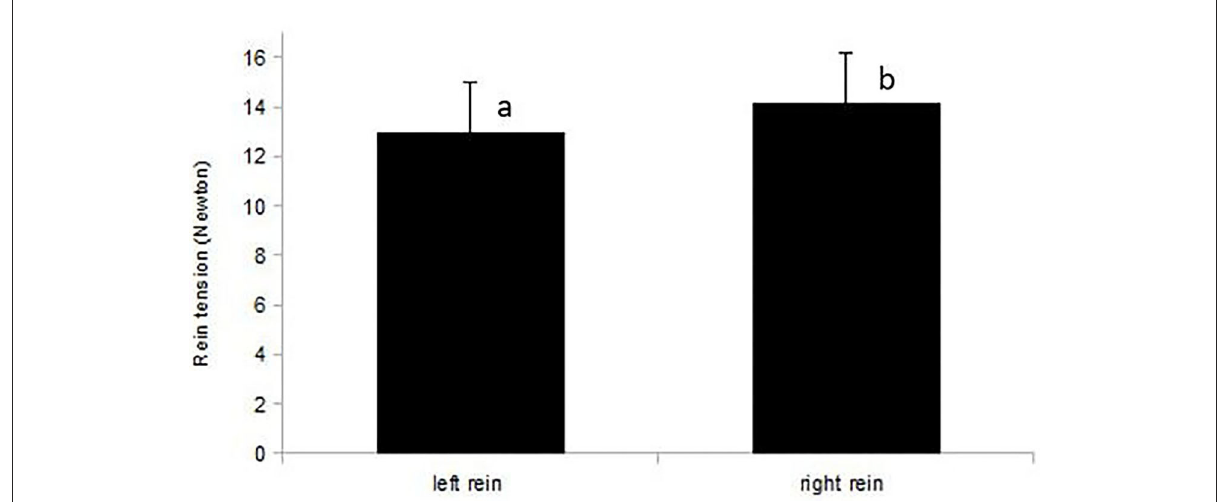
FIGURE5 Mean rein tension (N) of the left and right rein in right-handed riders ( n = 12 rides). Riders applied higher mean rein tension with their dominant, right hand ( p = 0.044). Different letters indicate a significant difference at p < 0.05.